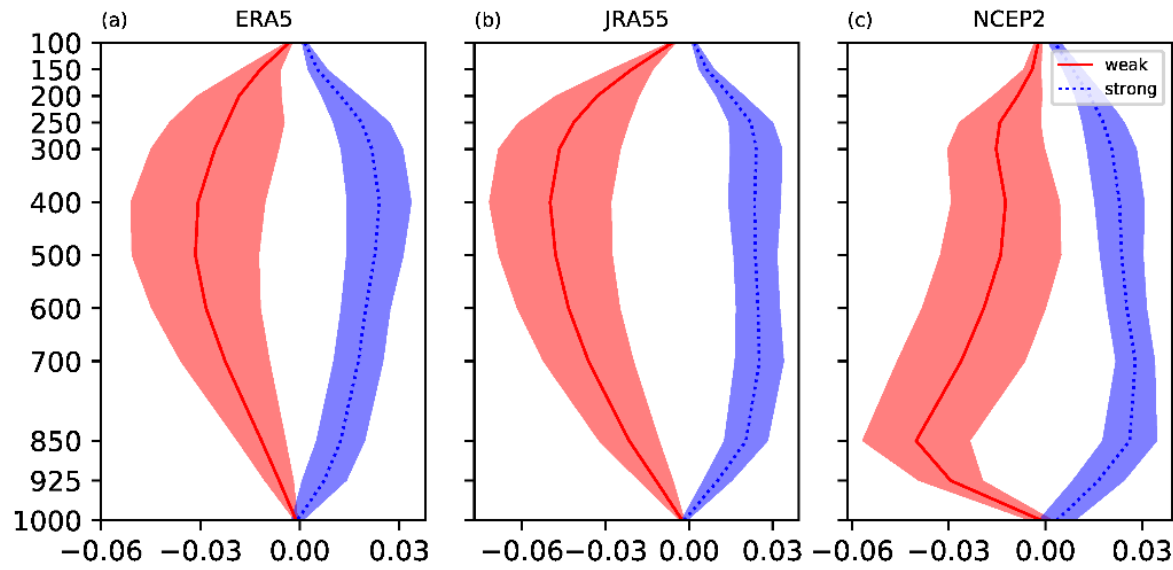
Figure 5. The contents are similar to Figure 4, but the areas squared are oceanic areas. ( a ) ERA5 datasets, ( b ) JRA55 datasets, and ( c ) NCEP2 datasets.